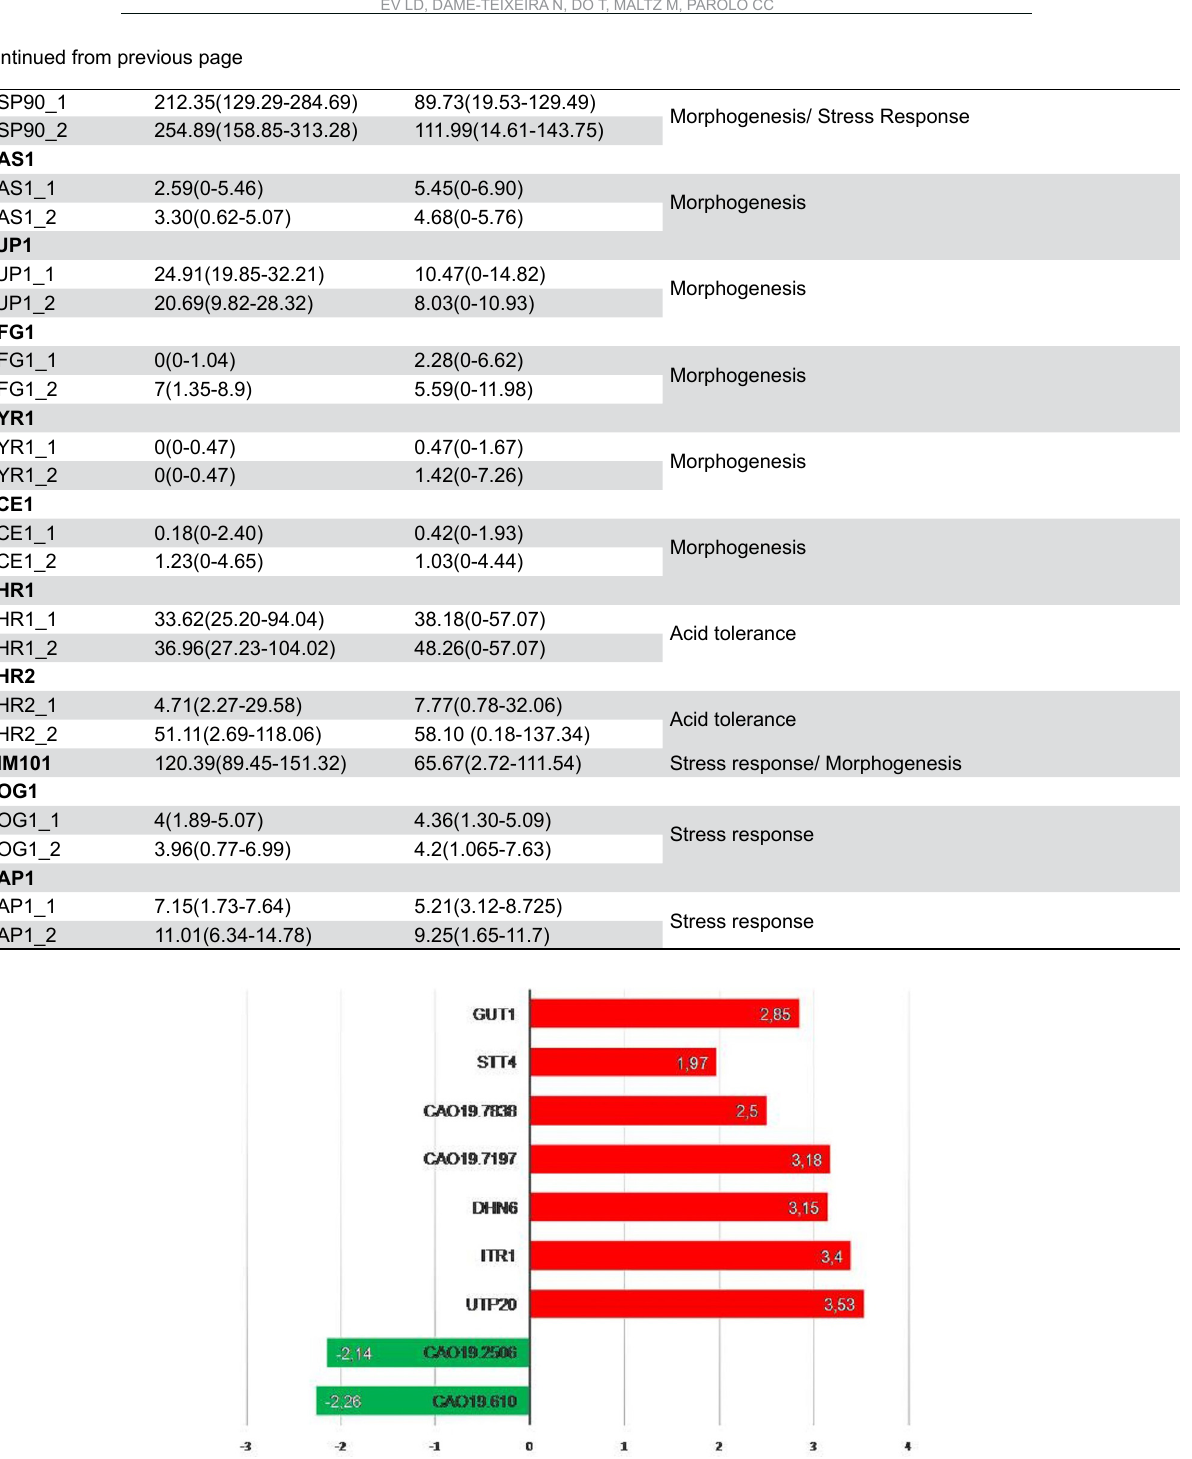
Figure 2- Differential expression (Log2FoldChange) of genes up-regulated in sound root surface (SRS; negative values, green bars) and up-regulated in root caries (RC, positive values, red bars) calculated using DESeq2 algorithms. FDR<0.05. GUT1= potential glycerol kinase; STT4= hypothetical protein phosphatidylinositol-4-kinase; CaO19.7838= flocullin-like protein serine-rich; CaO19.7197= hypothetical protein; DHN6= dehydrin hypothetical protein; ITR1= potential Myo-inositol transporter; UTP20= potential U3 small nucleolar RNAs protein; CaO19.2506= hypothetical protein with a very weak similarity to Streptoccal proline-rich surface protein PspC; CaO19.610= potential DNA binding regulator of filamentous